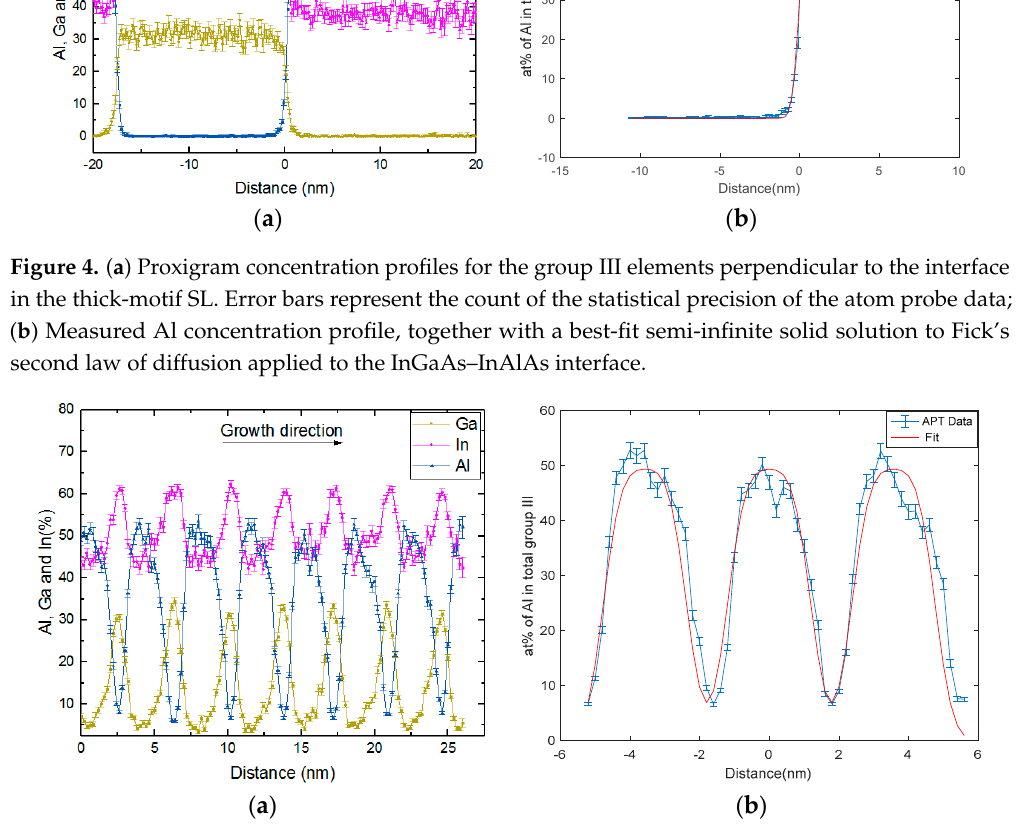
Figure 5. ( a ): Proxigram for thin-motif SL showing only group III concentrations. ( b ) Diffusion length estimation by fitting Fick’s law of diffusion to the Al content profile.